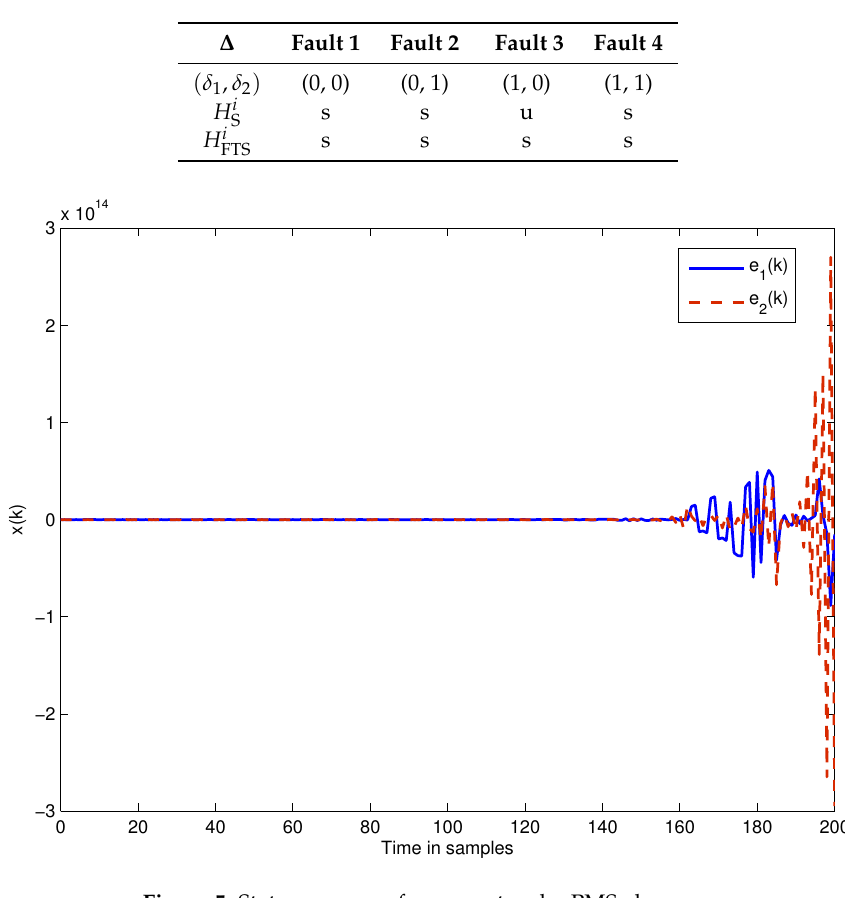
Table 2. Stability analysis of error system by two types of observers.